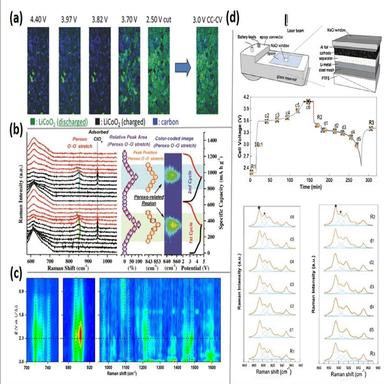
(a) In-situ Raman spectra of LiCoO2 electrodes using LiPF6 in EC/DMC as electrolyte during the first charge (Reproduced with permission from ref. Copyright 2013 The Electrochemical Society); (b) Raman spectra of Li-rich cathode material Li1.2Ni0.2Mn0.6O2 during the initial two cycles (Reproduced with permission from ref. Copyright 2018 Wiley–VCH); (c) operando SERS spectra of Au electrode in LP40 electrolyte with a scanning region of 0.5–3.0 V (Reproduced with permission from re